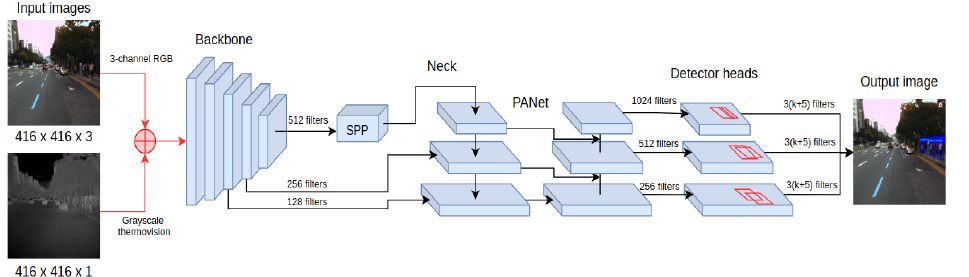
Figure 3. The processing pipeline of the YOLO4-RGB-T network combines RGB and thermal images into a 4-channel